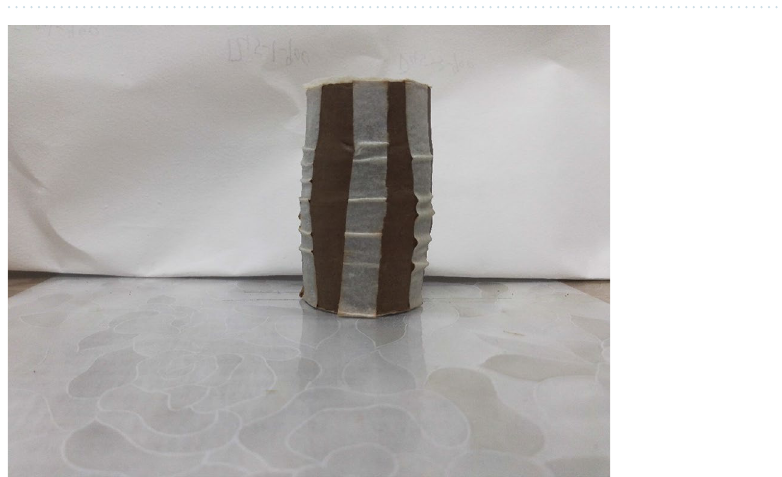
Figure 2. Experimental results of volumetric strain–axial strain curves of loess samples under different confining pressures.